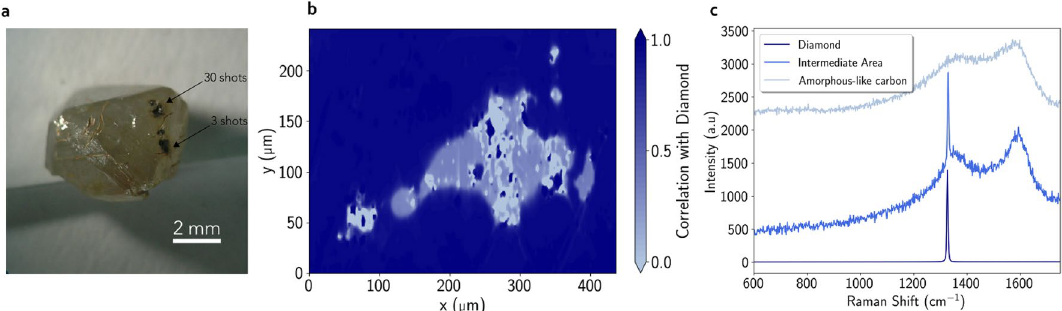
Figure 6. Observations of the LIBS craters performed in a diamond. ( a ) Image of the diamond used in this study. Two LIBS craters are visible as black spots, one made with 30 shots and one with 3 shots. ( b ) Raman mapping of the 3 shot deep crater. The color scale indicates the correlation with the out-of-crater diamond Raman spectrum. ( c ) Three spectra extracted from the map showing the transition from pure crystalline diamond to amorphous carbon inside the LIBS